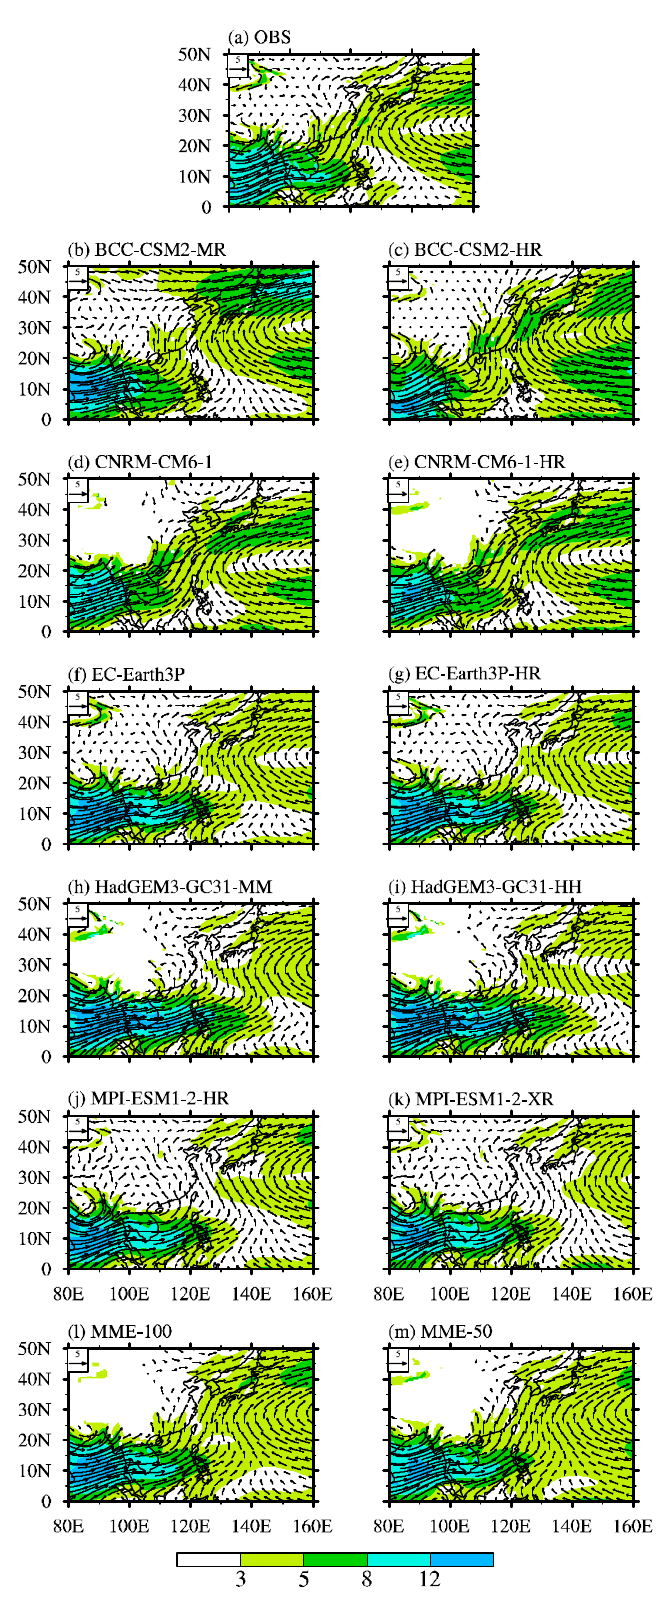
Figure 7. The climatological distributions of summer climatological mean 850-hPa horizontal winds (vectors, m s − 1 ) and wind speed (shaded, m s − 1 ) in the ( a ) observation, ( b – k ) models, ( l ) MME-100, and ( m )